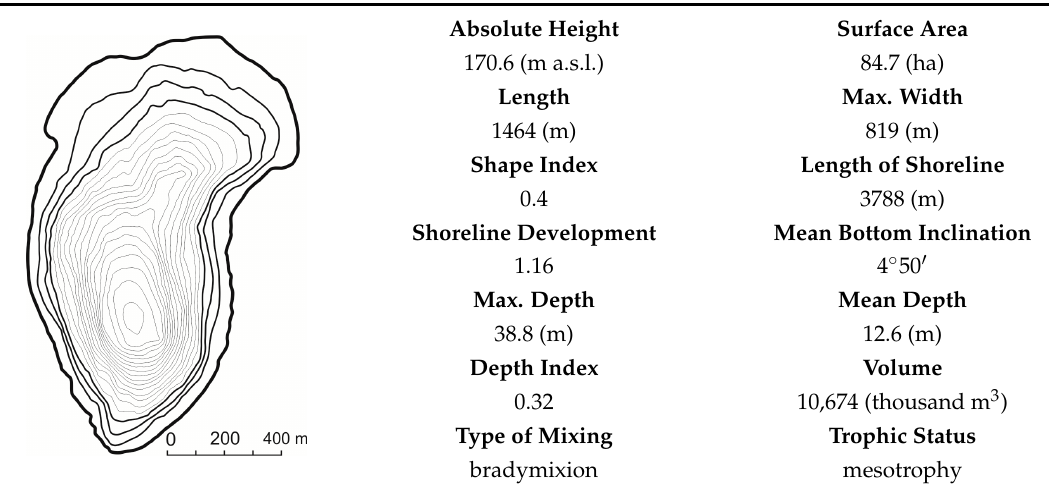
Figure 1. The location of Lake Piaseczno (white arrow) in the Łę czna-W ł odawa Lake District. Adapted from [32]. In the hydrographic division, Lake Piaseczno is included in the catchment of the Wieprz River, in the upper part of the catchment of the Piwonia Po ł udniowa River. The river originates in the vicinity of the lake, and has no surface connection with it. Therefore, its catchment is described as a surface-closed-drainage catchment [33]. Lake Piaseczno is classified as a very deep lake, with a maximum depth of 38.8 m and a high water volume (10.67 million m 3 ). It is a dimictic lake in the bradymictic type, and, in terms of trophic status, it is mesotrophic (Table 1). Table 1. The morphometric parameters of Lake Piaseczno on the background of its bathymetric plan (a.s.l., above sea level) [33].